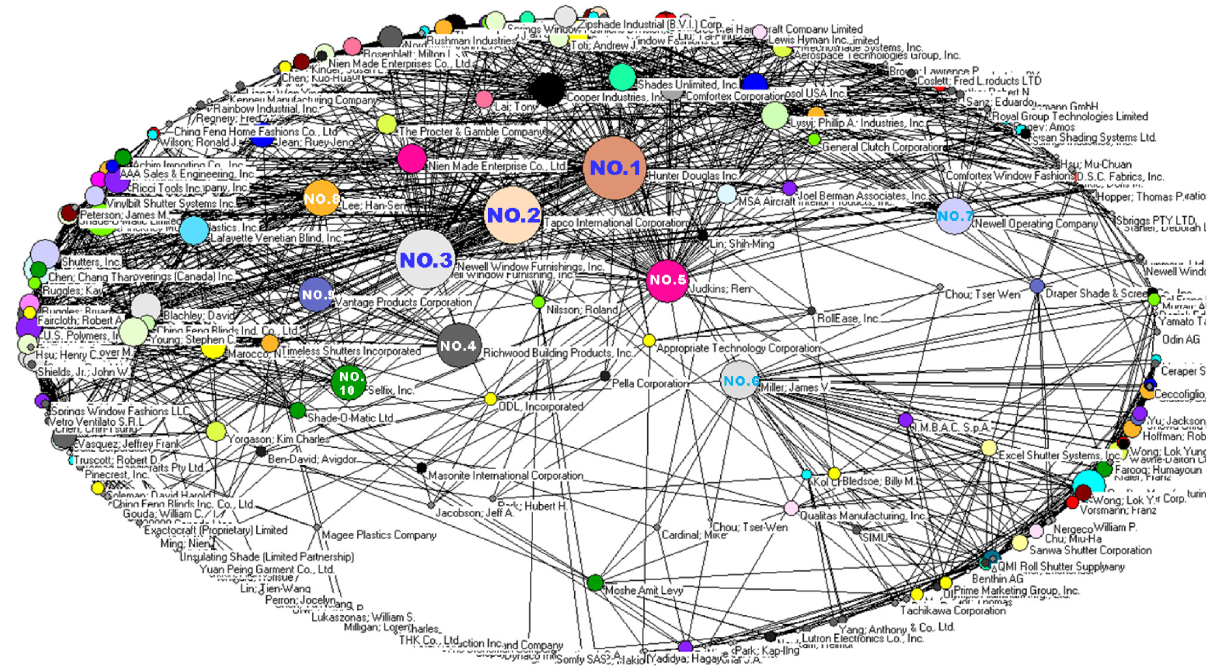
Fig. 6. The linkages between patent assignees in the technology field (patent assignee